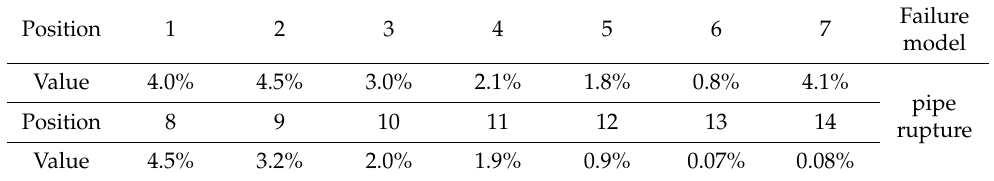
Table 4. The tensile strain result of strain gauges in Figure 14c during the maximum load.